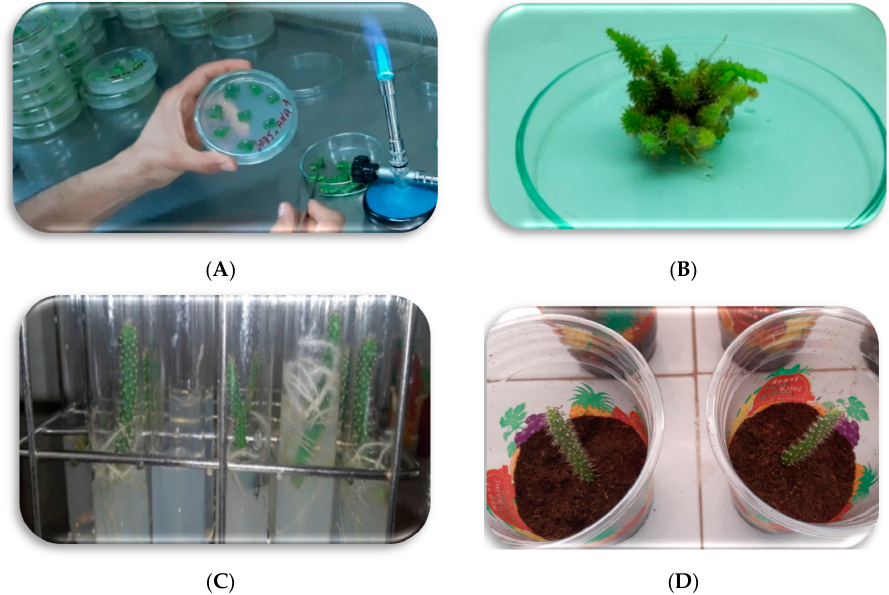
Figure 2. Micropropagation of wild prickly pear ( A – D ). ( A ) Areole incubation of one cm 2 under sterile conditions. ( B ) Multiple shoot formation from a single explant on MS medium supplemented with BAP 5.0 mg/L. ( C ) Rooting in shoots on MS supplemented with kinetin 1.5 mg/L. ( D ) gradual acclimatization of plantlet.